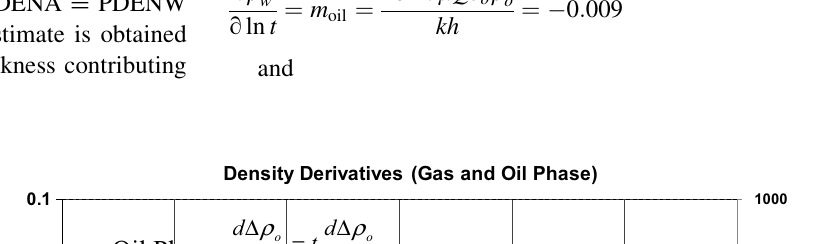
Fig. 13 Oil and gas densities derivative versus time showing good stabilisation without numerical artefact in the gas density